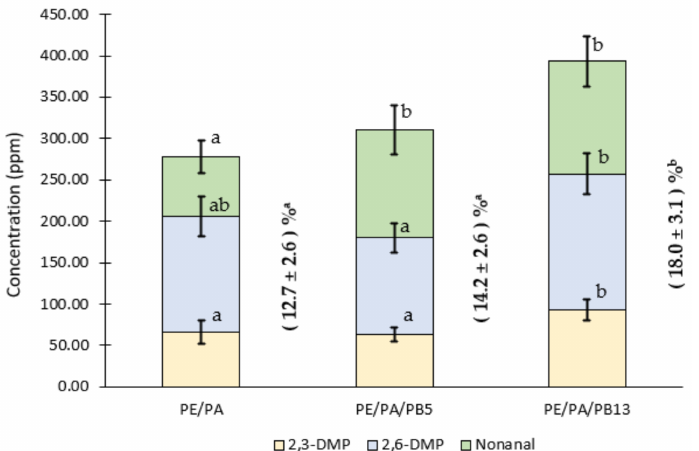
Figure 5. Concentration (ppm) and retention capacity (%) of 2,3-DMP, 2,6-DMP and nonanal present in PE/PB-based films after processing. Different superscripts within the same compound for the different formulations indicate statistically significant different values ( p < 0.05). Different super- scripts within the values of the sum of the individual retentions (%) of the main aroma compounds (i.e., 2,3-DMP, 2,6-DMP and nonanal) for the different formulations indicate statistically significant different values ( p <